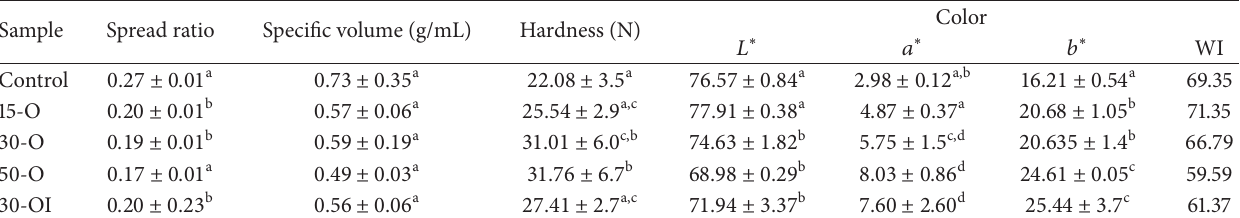
Table 2: Physical properties of